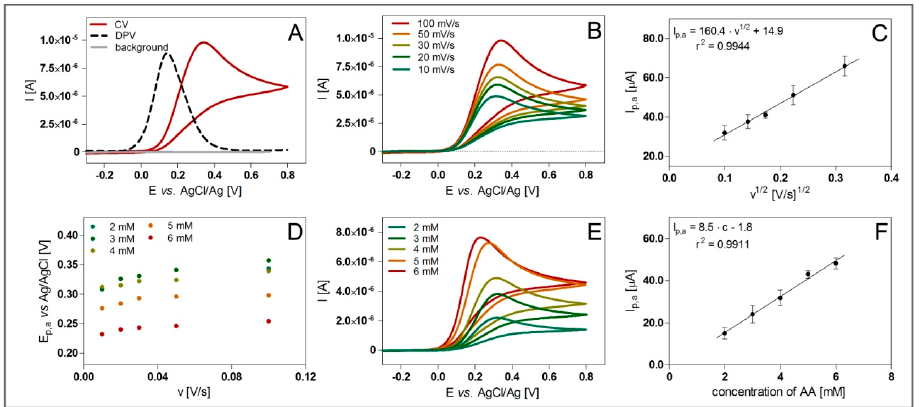
Figure 1. ( A ) CV—cyclic voltammogram DPV—differential pulse voltammogram; c = 4 mM, potential scan rate (v) 100 mV/s. ( B ) CVs, c = 4 mM at various v; 100 mV/s, 50 mV/s, 30 mV/s, 20 mV/s, 10 mV/s of the supporting electrolyte. ( C ) The dependence of the anodic peak current (I p,a ) on the square root of v, c = 4 mM. ( D ) The dependence of the anodic peak potential (E p,a ) on the v for various concentrations: 2 mM, 3 mM, 4 mM, 5 mM, 6 mM. ( E ) CVs for various concentriatons, v =